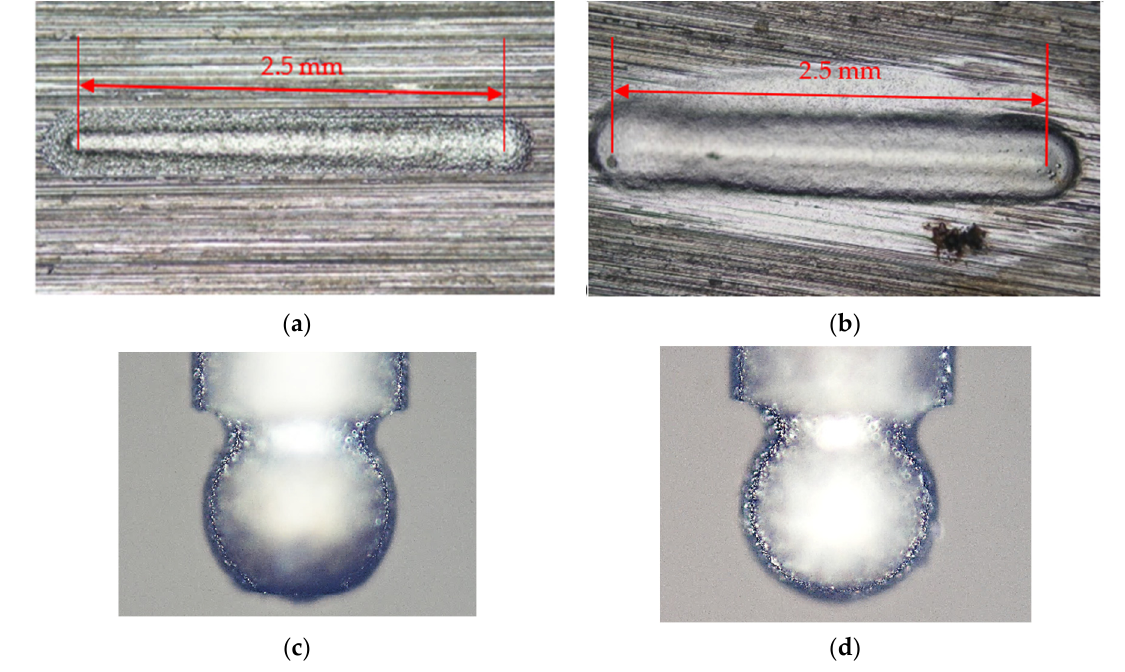
Figure 15. Comparison between ( a ) kerosene micro-EDM and ( b ) DI-water ECM with ( c , d ) micro- spherical tool of 0.35 mm diameter in one-step processing.